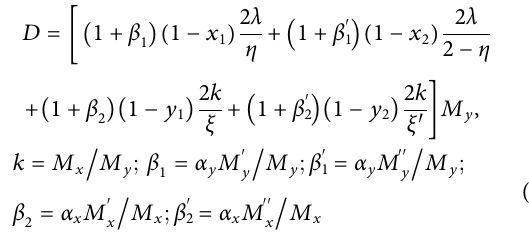
FIGURE 8 | Flow chart of the present